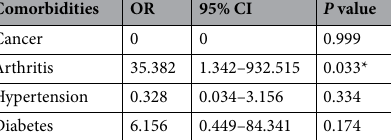
Table 4. Significance of comorbidities by multiple logistic regression. CI confidence interval, OR odds ratio. * p <